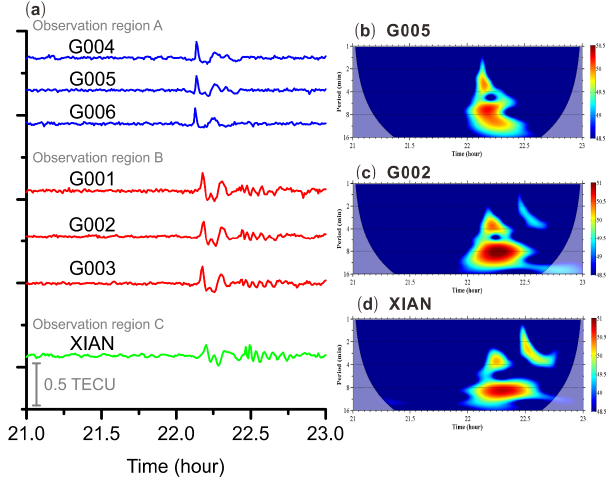
Figure 4. (a) The high frequency part of filtered ionospheric STEC time series for satellite PRN16 of all the seven GPS stations on the day of Shenzhou-8 launch (DOY = 304) in three observation re- gions A, B and C by setting a cutoff period of 12min; (b) the local wavelet power spectrum of GPS station G005 for satellites PRN16; (c) the local wavelet power spectrum of GPS station G002 for satel- lites PRN16; (d) the local wavelet power spectrum of GPS station XIAN for satellites PRN16.